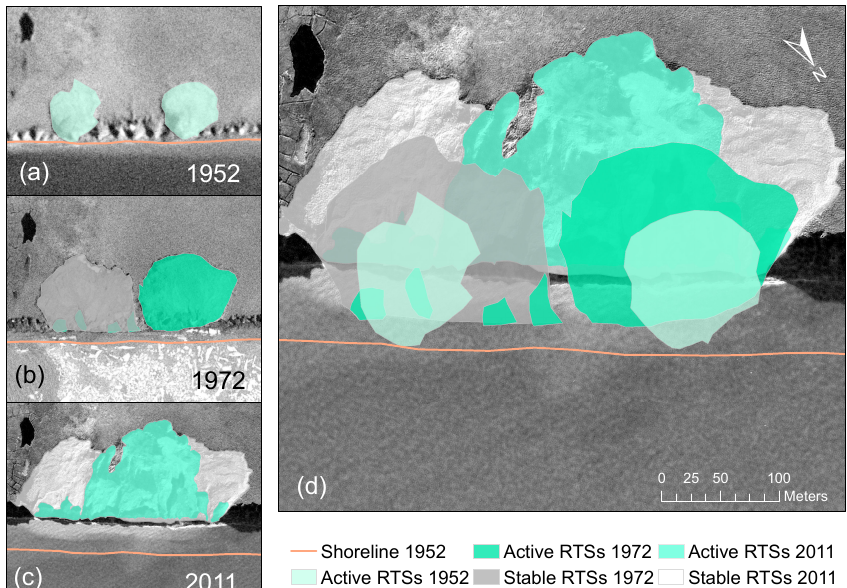
Figure 2. Geomorphological map of retrogressive thaw slumps (RTSs) illustrating the complexity of RTS evolution along the Yukon Coast. (d) RTSs identified in 1952 (a) and in 1972 (b) overlap the 2011 RTSs (c) . The underlying imagery is a GeoEye-1 satellite image from 2011 (18 July). RTS areas from 1952 and 1972 closer to the shore have eroded due to coastal retreat. The remaining parts have either extended and merged with other RTSs or stabilized in 2011. (a) Two active RTSs in 1952 (aerial photo from 1952, National Air Photo Library, Canada). (b) RTSs in 1972 (aerial photo from 1972, National Air Photo Library, Canada). RTSs expanded and one had stabilized. New active RTSs developed within the stabilized RTS. (c) RTSs in 2011 (GeoEye-1, 18 July 2011). Former RTSs had partly stabilized and newer RTSs developed within the boundaries of the stabilized